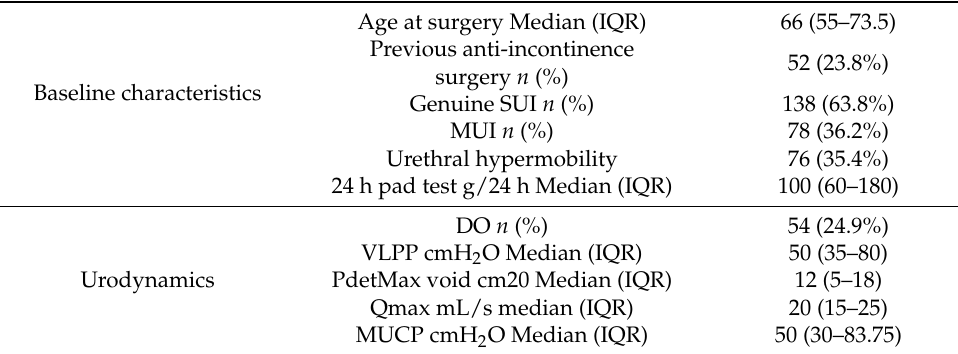
Table 1. Baseline characteristics of the study population.